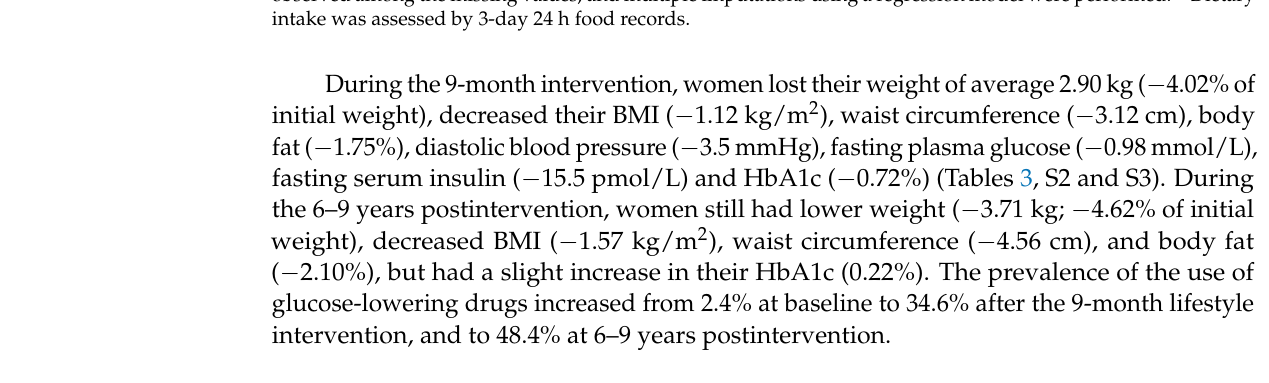
Table 3. Changes in selected clinical and metabolic variables from baseline to the end of Month 9 and Years 6–9